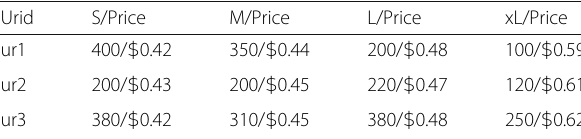
Table 2 Sample of on-demand user requests collected by the CMB (urSLA)